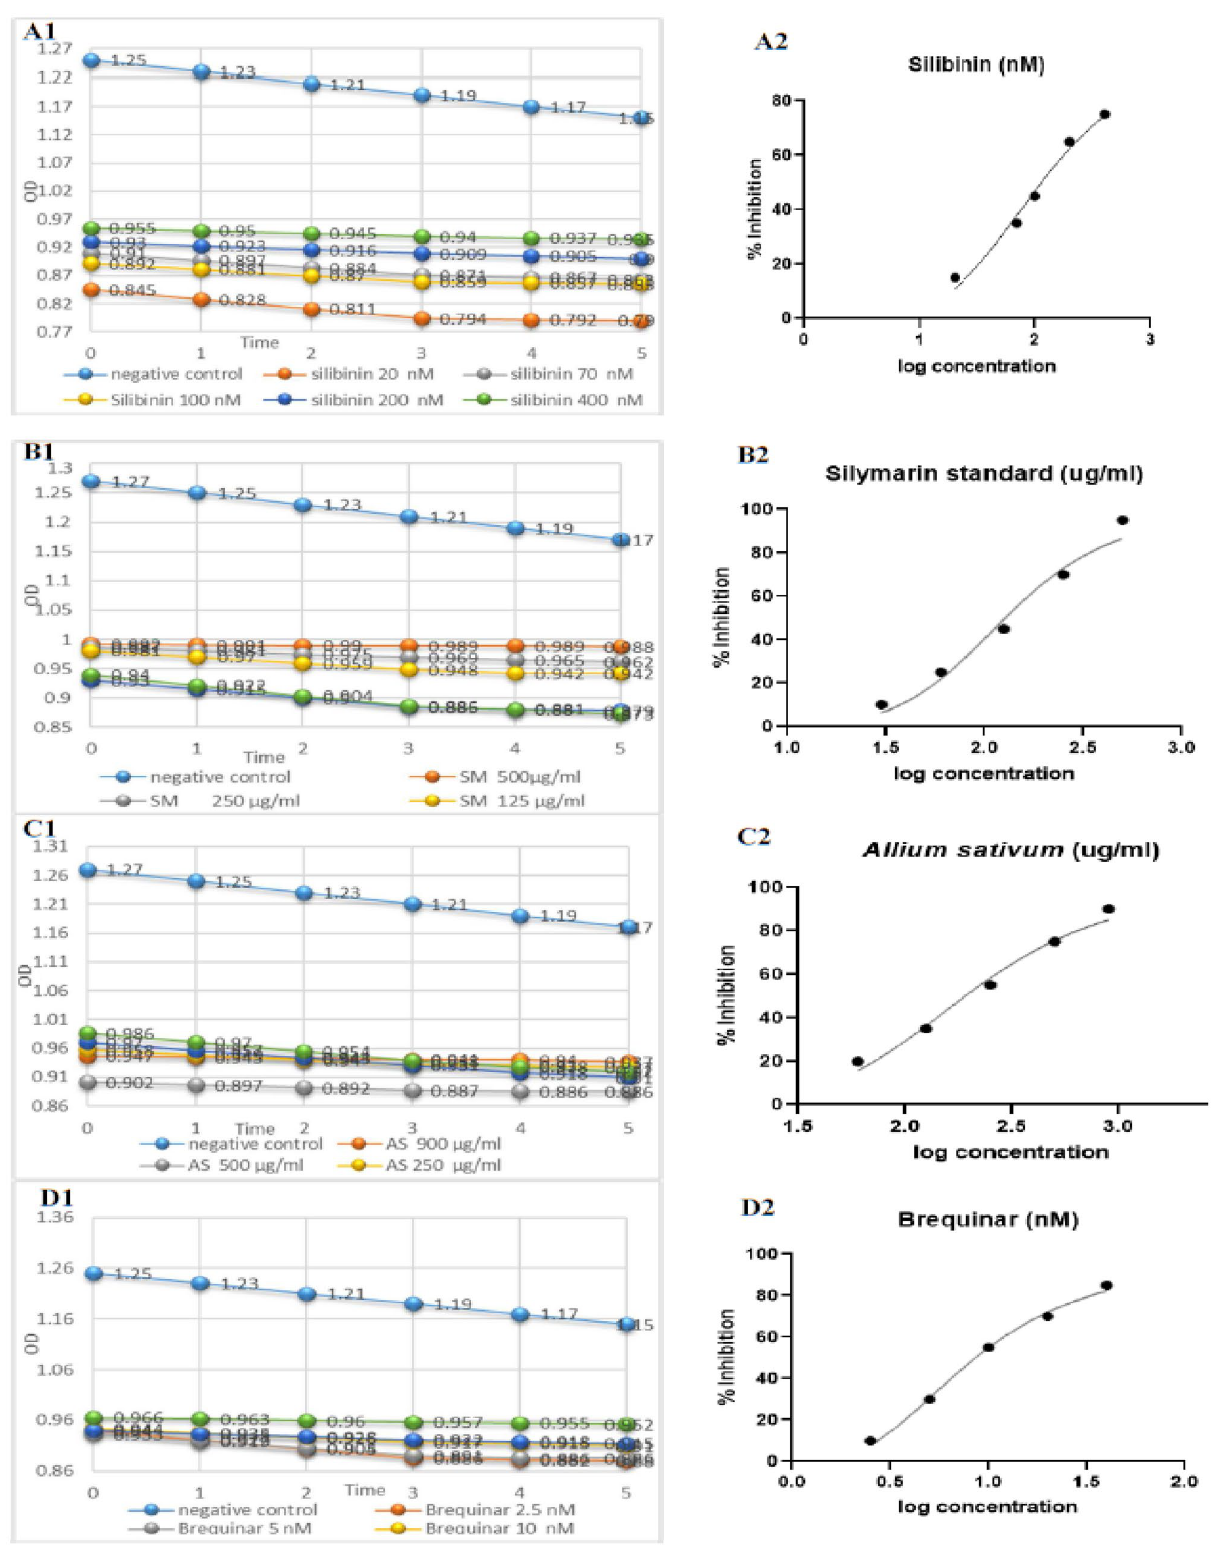
Figure 10. Time-absorption (to the left) and dose response (to the right) curves of silibinin ( A ), silymarin standard extract ( B) , Allium sativum extract ( C ) and the reference drug; brequinar ( D